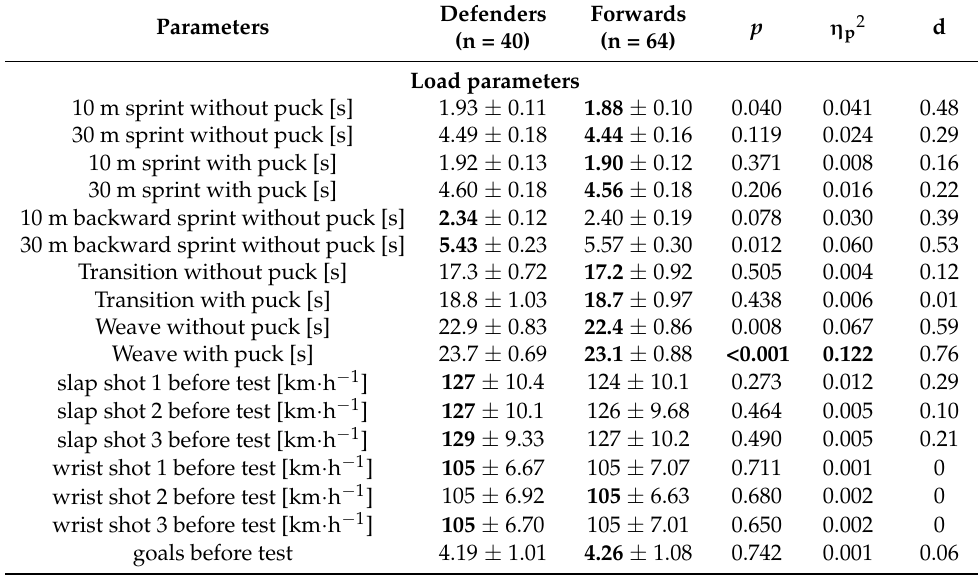
Table 7. Differences in load and stress parameters (Mean ± standard deviations (SD)) by playing position. Significant differences ( p ≤ 0.002) and (performance) maxima marked in